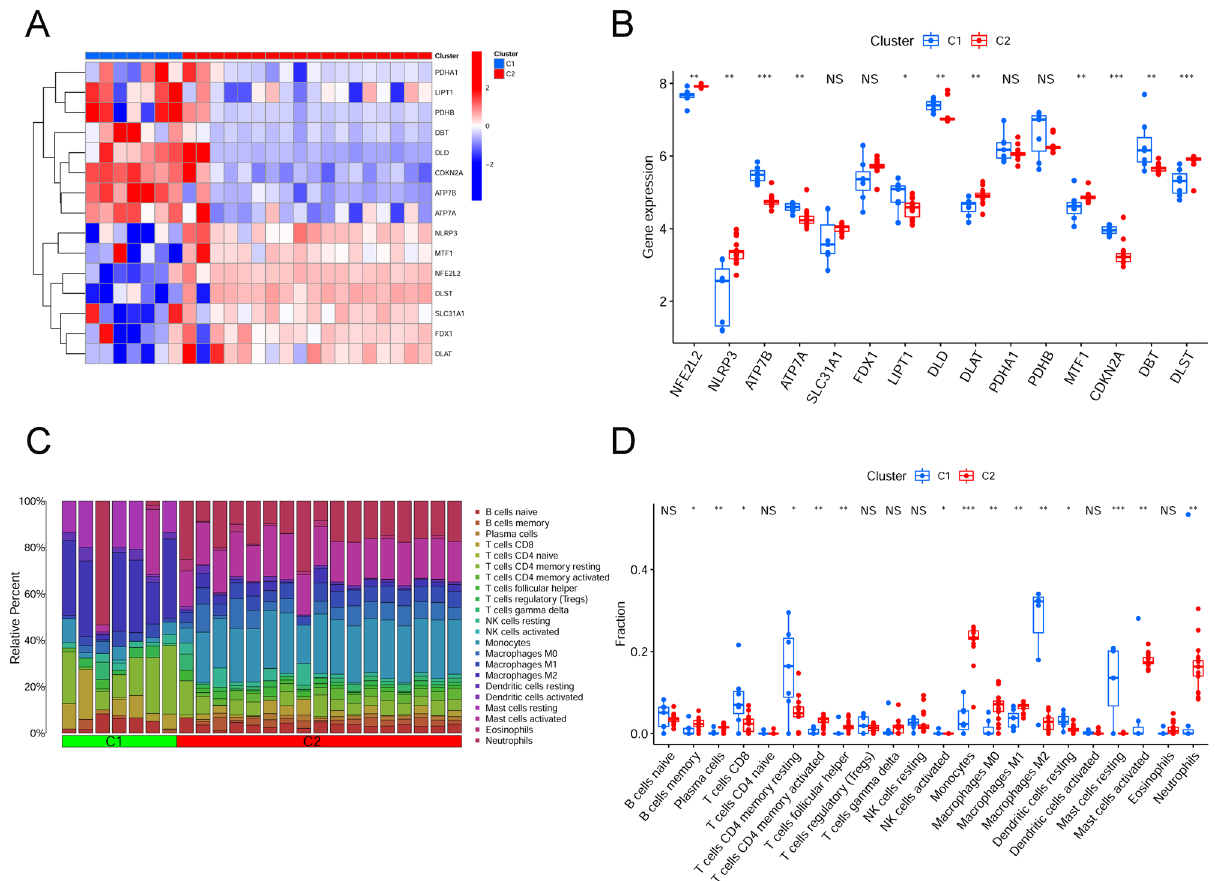
Figure 4. Identification of CRGs and immune features between two cuproptosis clusters. ( A ) Heatmaps showed the expression patterns of 15 differentially expressed CRGs between two cuproptosis clusters. ( B ) The differential expression of 15 differentially expressed CRGs between two cuproptosis clusters were presented in boxplots. ("***" = P < 0.001, "**" = P < 0.01, "*" = P < 0.05, "NS" = no significance) ( C ) Bar plot displayed the relative percent of 22 infiltrated immune cells between two cuproptosis clusters. ( D ) The differences in immune infiltrating between two cuproptosis clusters were presented in boxplots. ("***" = P < 0.001, "**" = P < 0.01, "*" = P < 0.05, "NS" = no